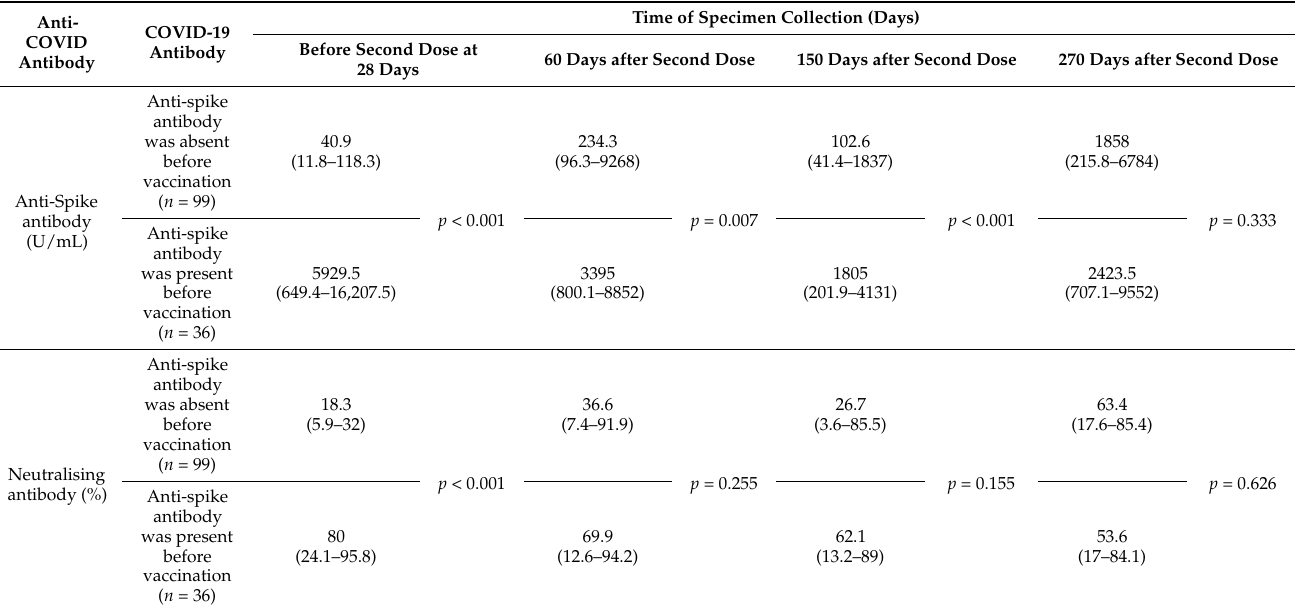
Table 3. Comparison of COVID-19 antibody response between those with or without pre-existing anti-spike antibody before vaccination in overall cohort ( n = 135).